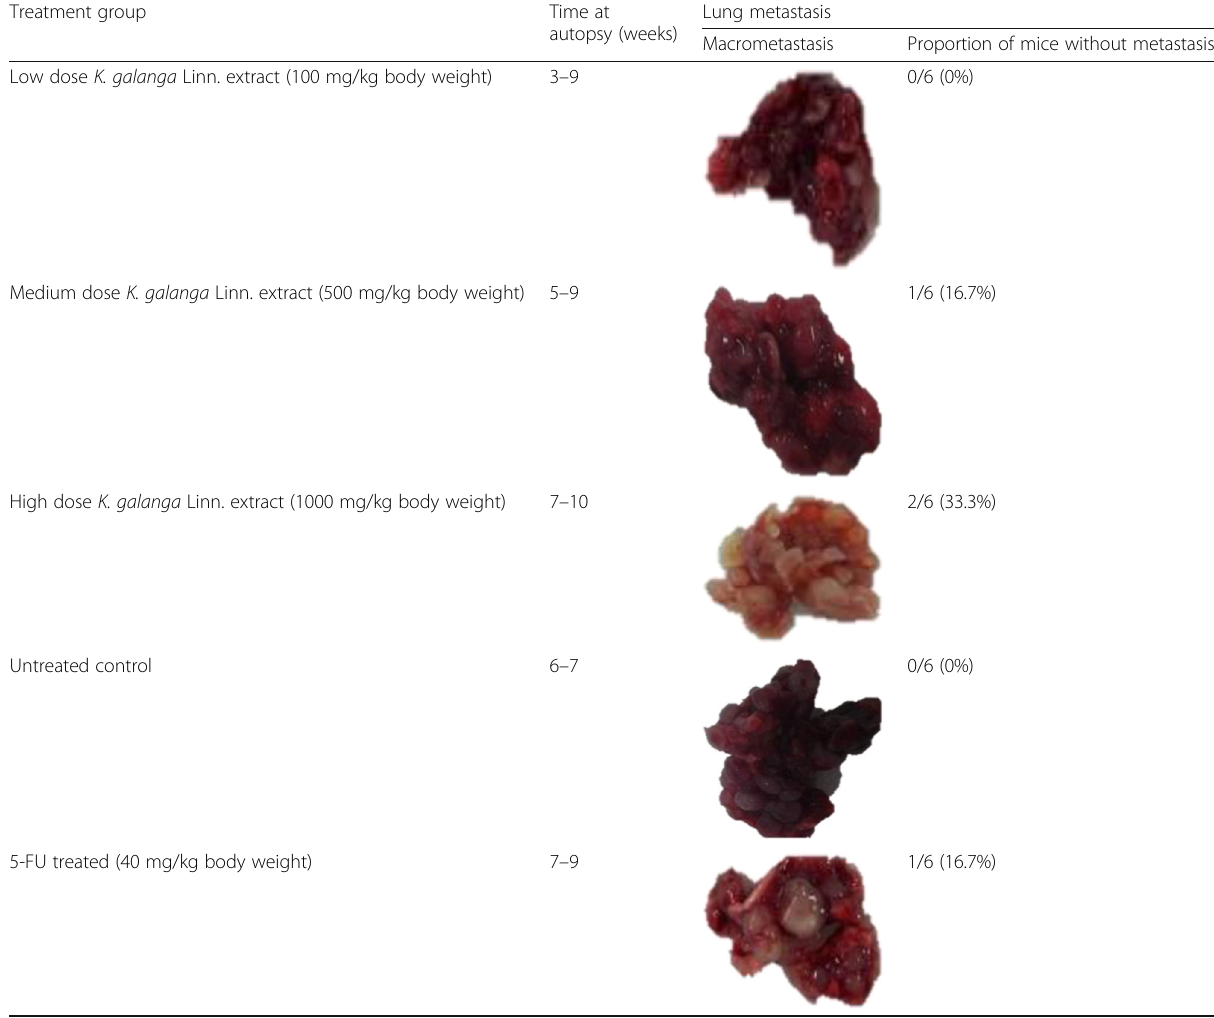
Table 3 Representative tumor metastasis and proportion of mice with metastasis in CL-6 xenografted nude mice treated with K. galanga Linn. extract and control (untreated and 5-FU) groups Treatment